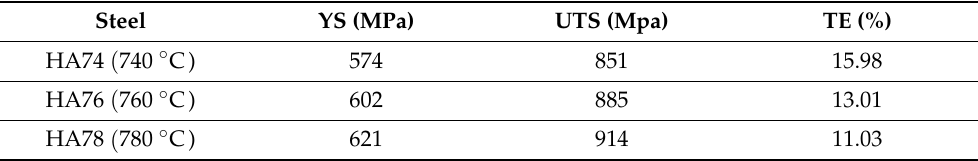
Table 2. Tensile properties of DP steels with different intercritical annealing temperatures [55]. Reprinted with permission from ref. [55]. Copyright 2021